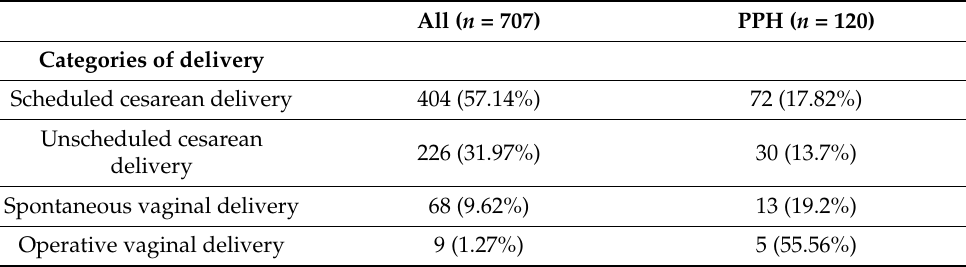
Table 2. Variables associated with PPH after univariate analysis expressed as numbers and